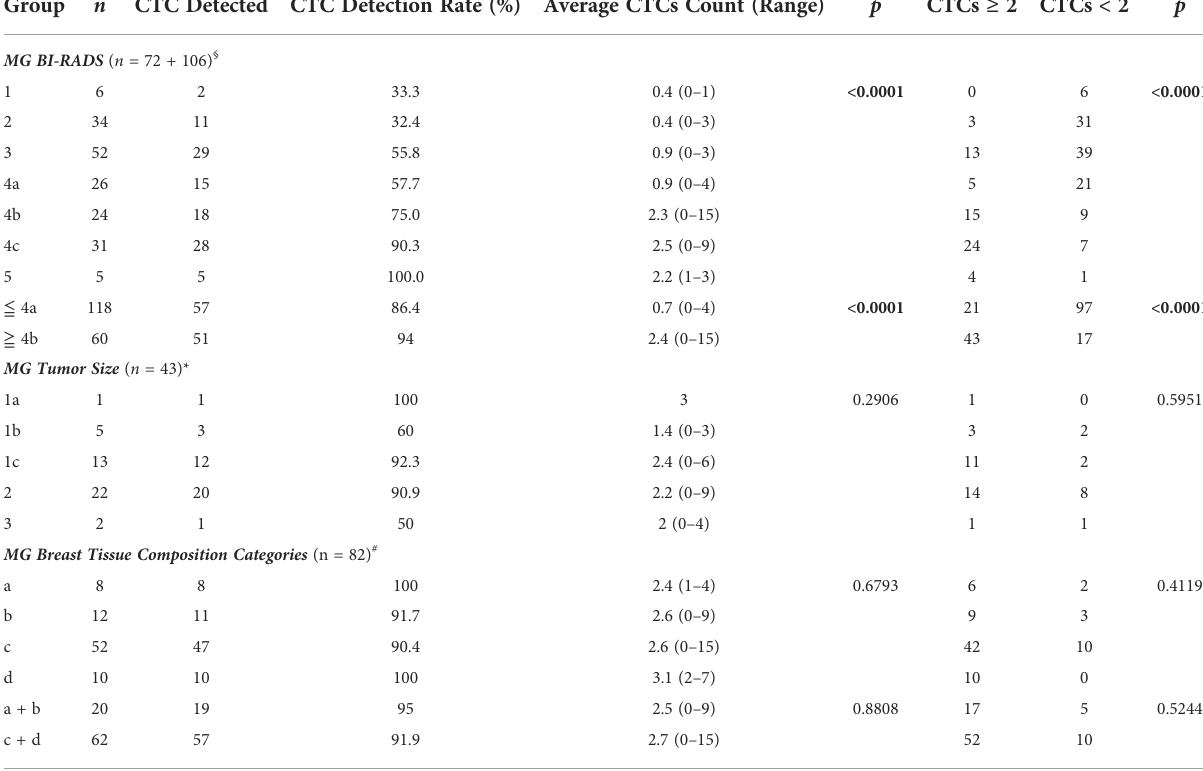
TABLE 4 Correlations of CTC testing and mammography in BC diagnosis.